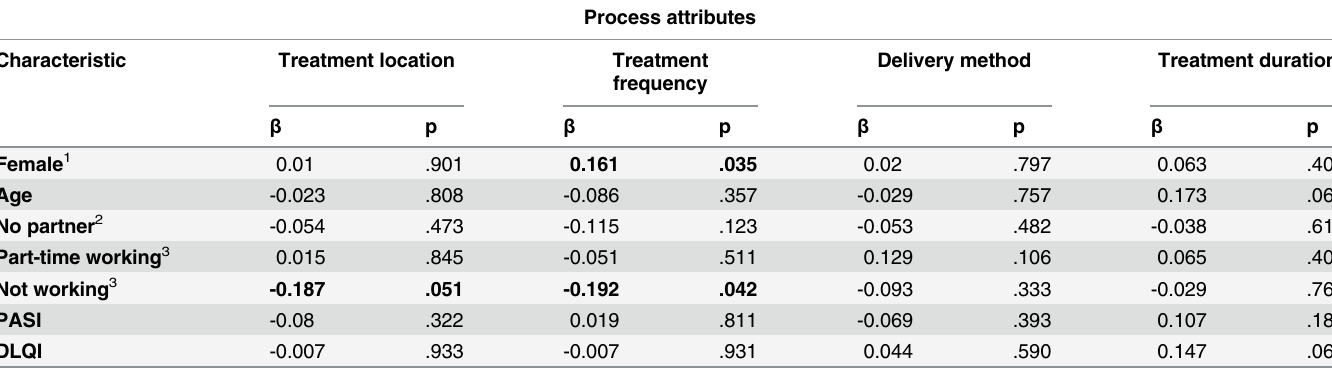
Table 5. Multivariate linear regression models for process attributes.